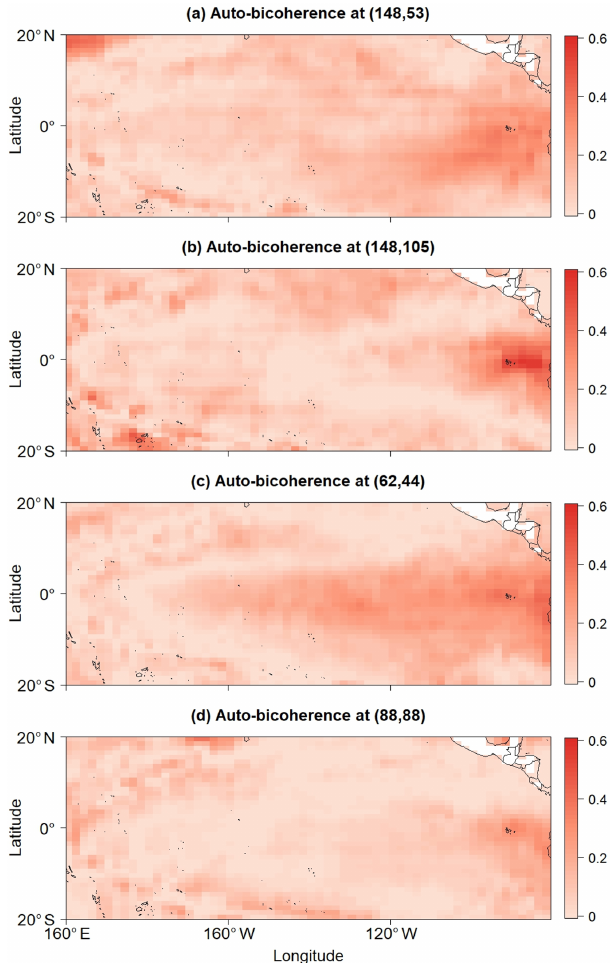
Figure 13. (a, b, c, d) Global auto-bicoherence corresponding to the monthly pairs, namely (158, 43), (148, 105), (62, 44), and (88, 88),